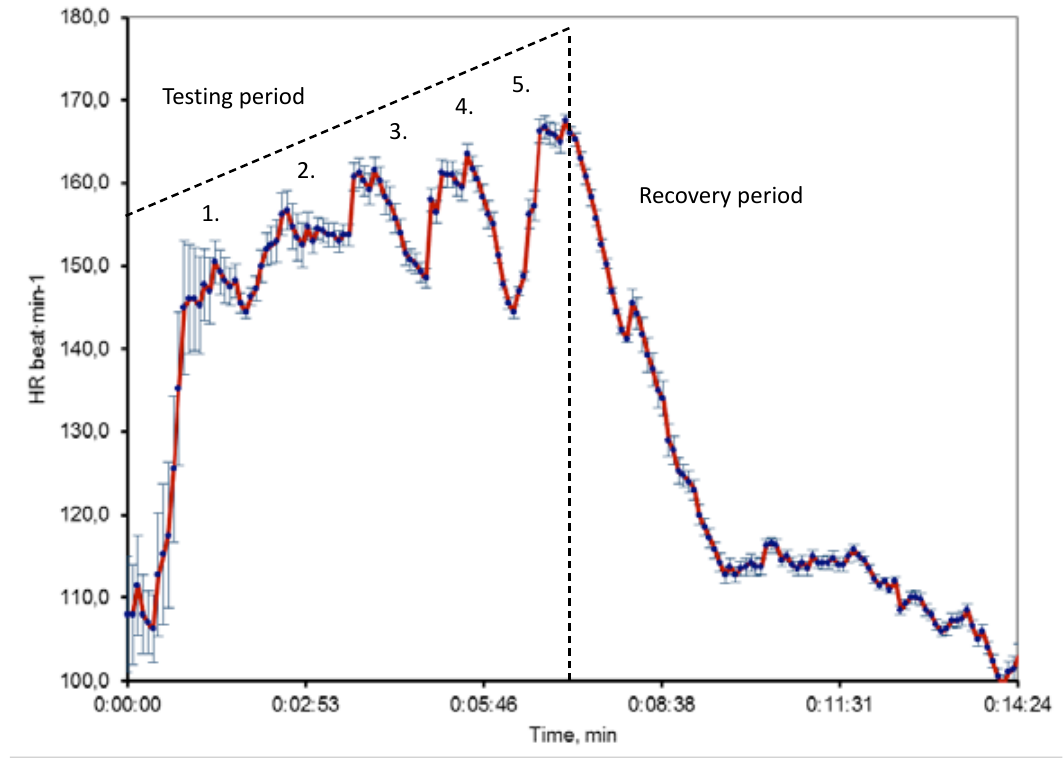
Fig. 1. Heart rate dynamics during performing 5 series of 15 throws at a maximum pace with 1-minute rest interval between series (average data for a group of wrestlers): 1–5 - mark of the series of performed